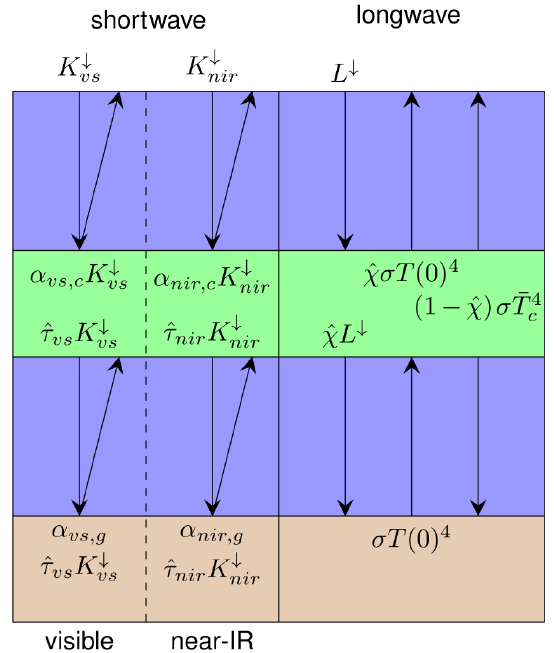
Figure A26. Longwave and shortwave radiation fluxes between the ground (brown), canopy (green), and overlying atmosphere. The meaning of each arrow is given at its tail. All variables are defined in the